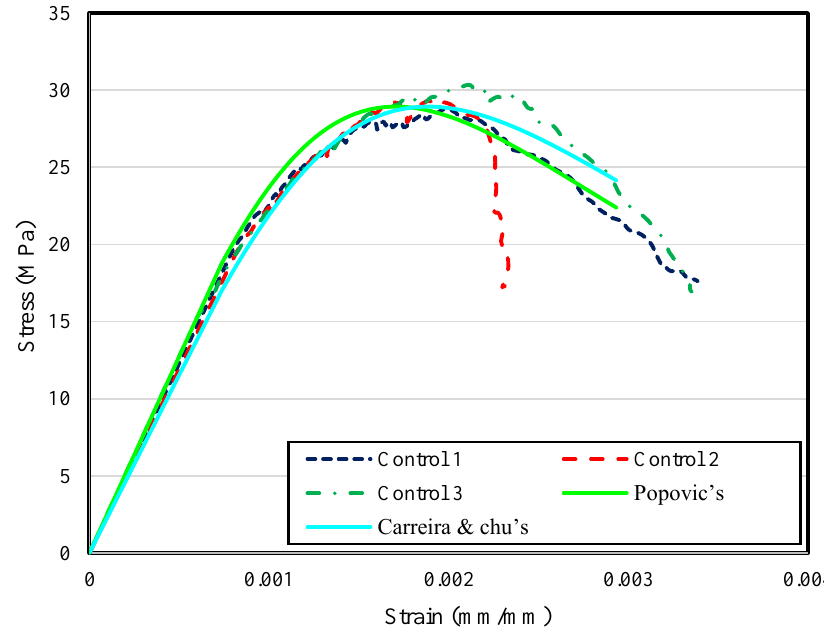
Figure 21. Comparison of stress-strain curves of control mix with existing constitutive models.